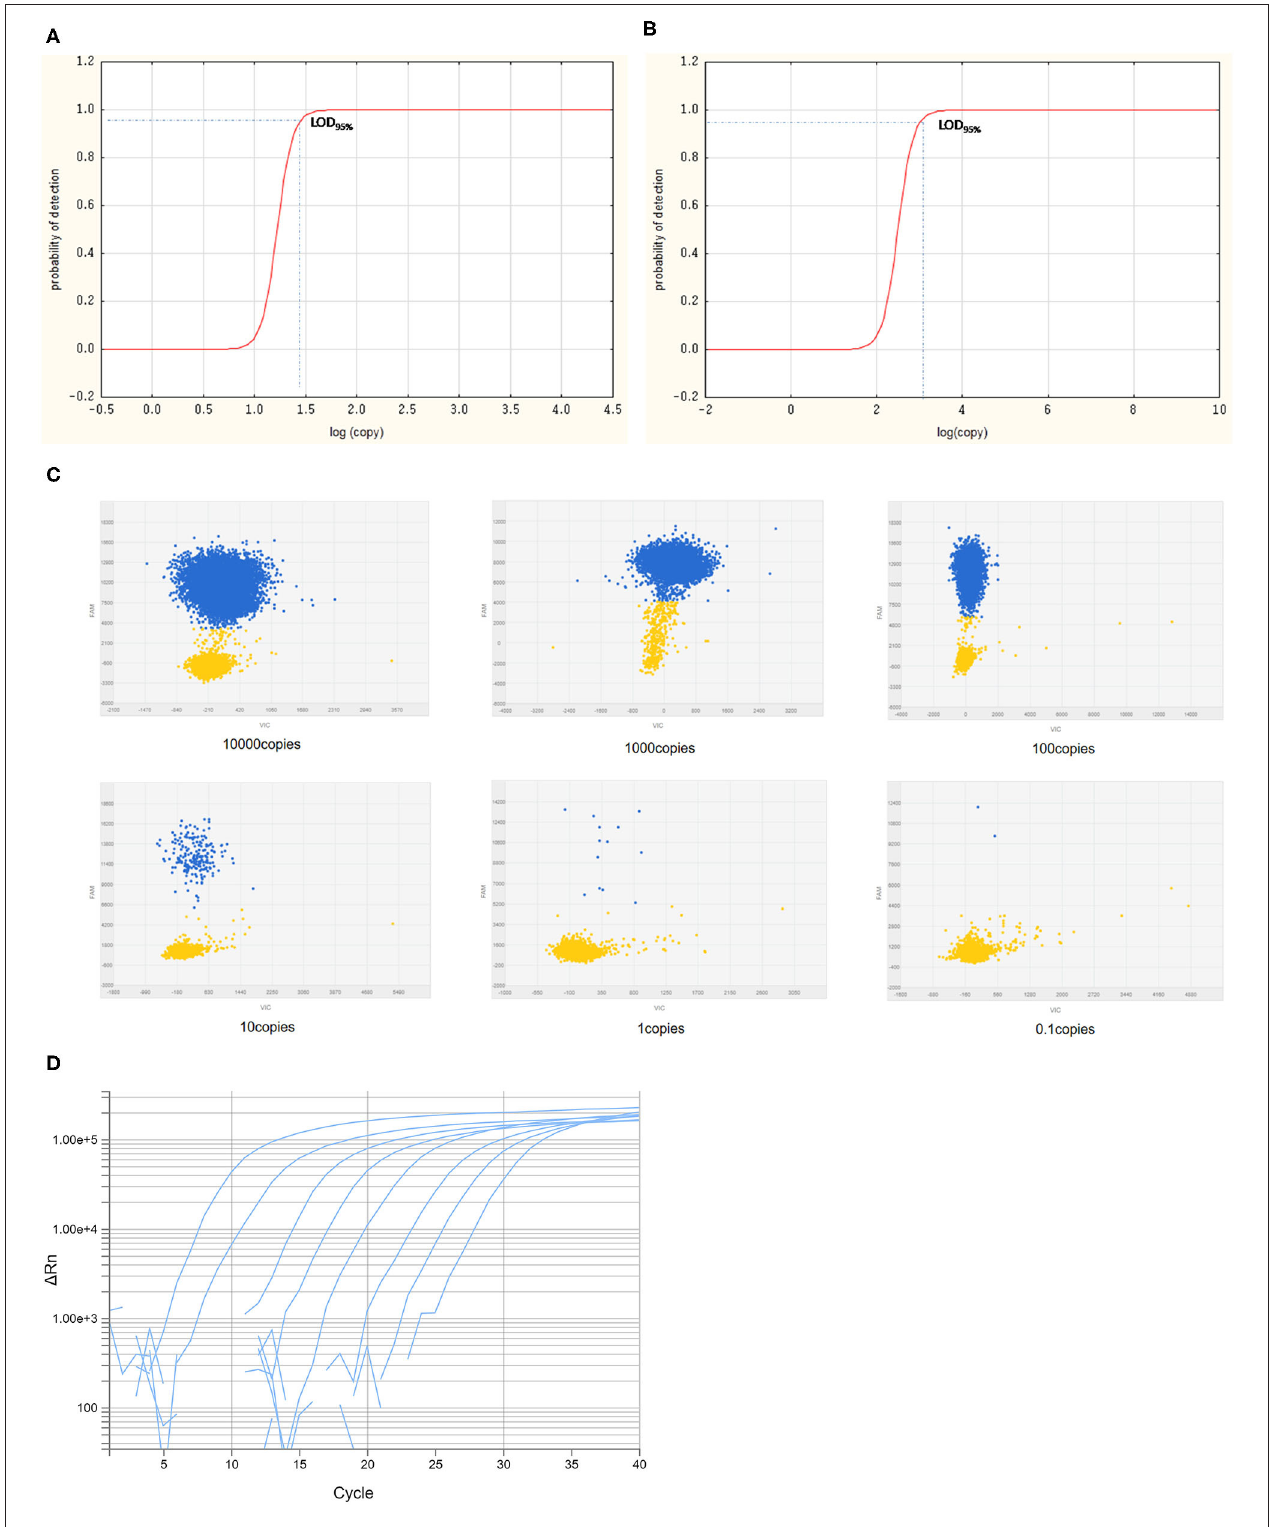
FIGURE 5 | The LOD 95 % of cdPCR and qPCR assay. Logit analysis plots of the cdPCR (A) and qPCR (B) used in the study show the LOD 95 % , which are the minimum amounts of DNA detectable with a 95% probably. The amplification curve of cdPCR (C) and qPCR (D) is obtained with 10-fold diluted standard plasmids.